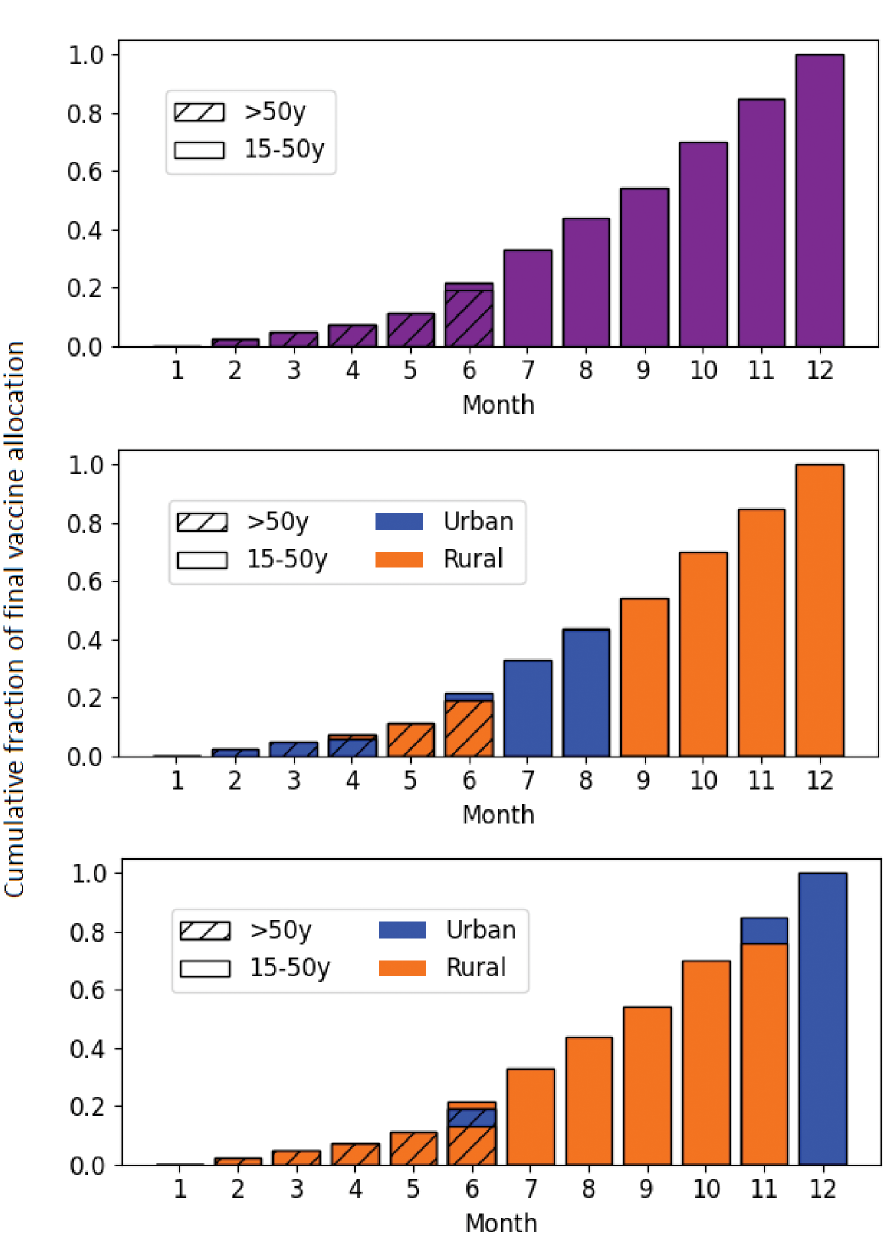
Fig 3. Ramp-up of protective effect within a vaccinated individual in the